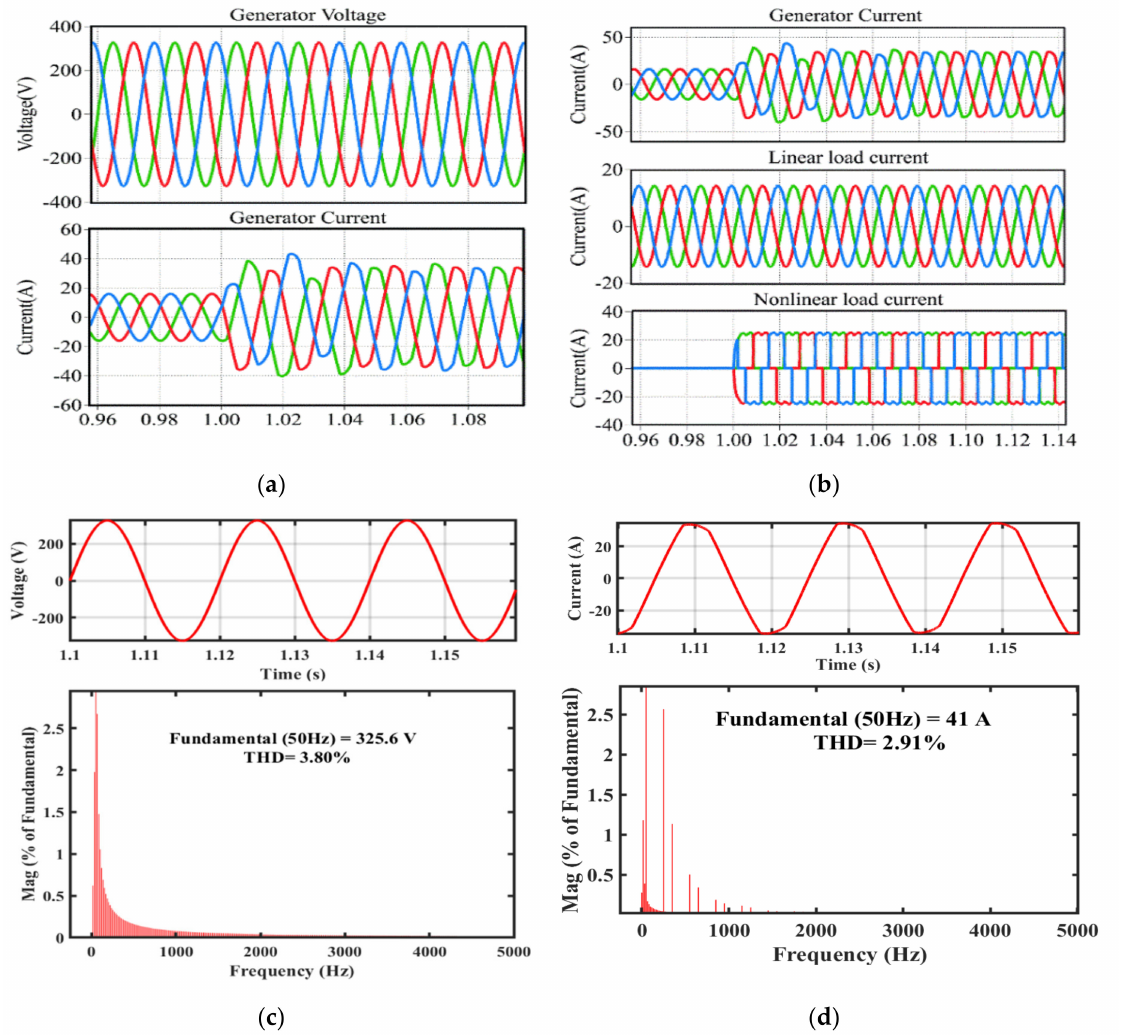
Figure 10. Overall results without control at PCC; ( a ) generator voltage and current signals with control; ( b ) overall system current signals with control; ( c ) harmonics spectrum of generator voltage with control; ( d ) harmonics spectrum of generator current with